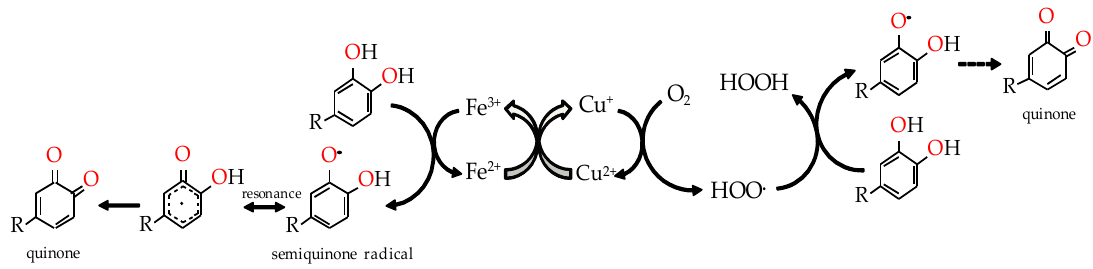
Figure 3. Catalytic action of iron and copper ions in the oxidation of catechols for the generation of quinones and hydrogen peroxide.